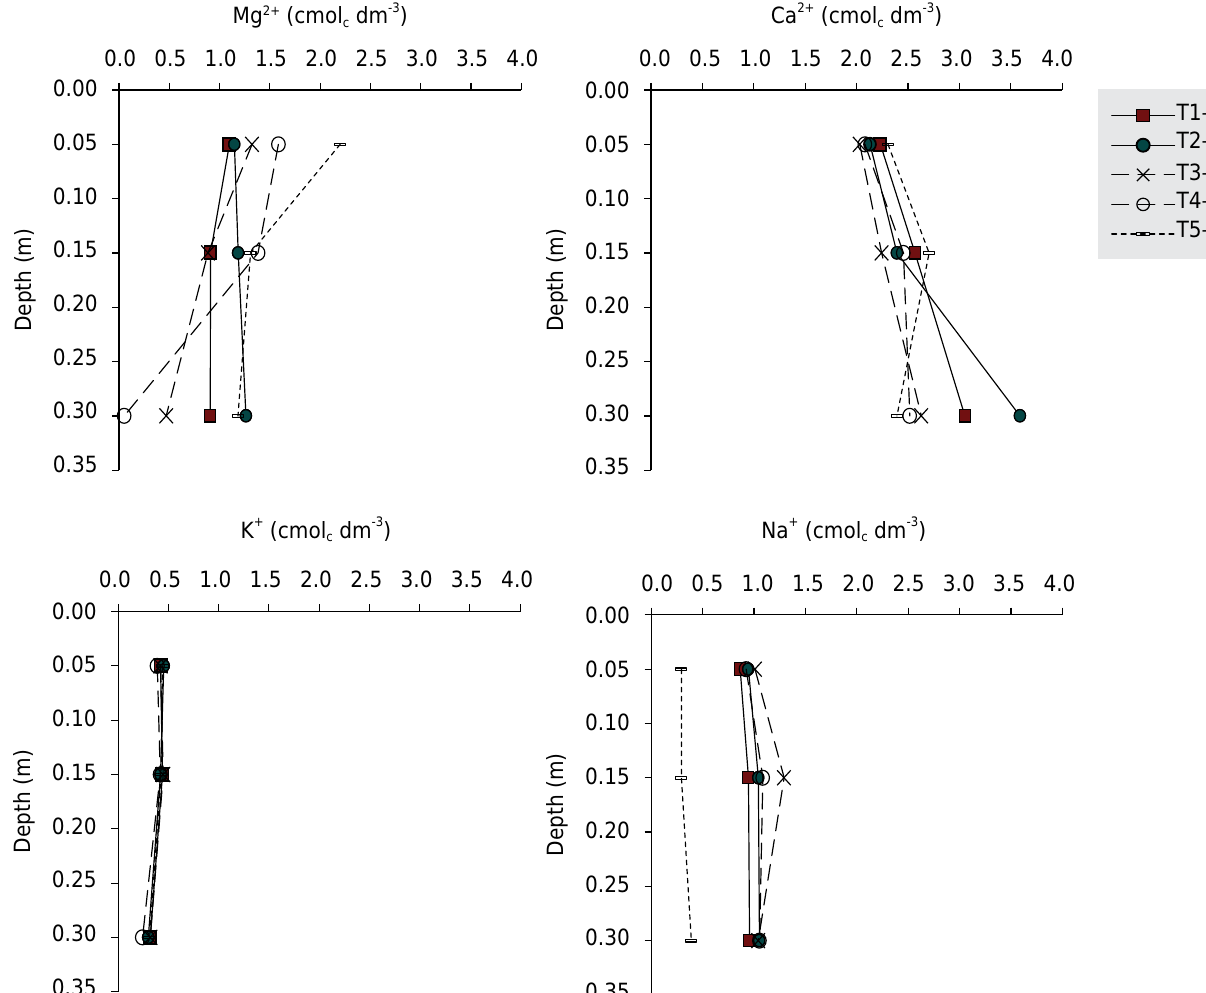
Figure 3. Average values of soil exchangeables magnesium, calcium, potassium and sodium, in the 0.00-0.10, 0.10-0.20, and 0.20-0.40 m layers after the